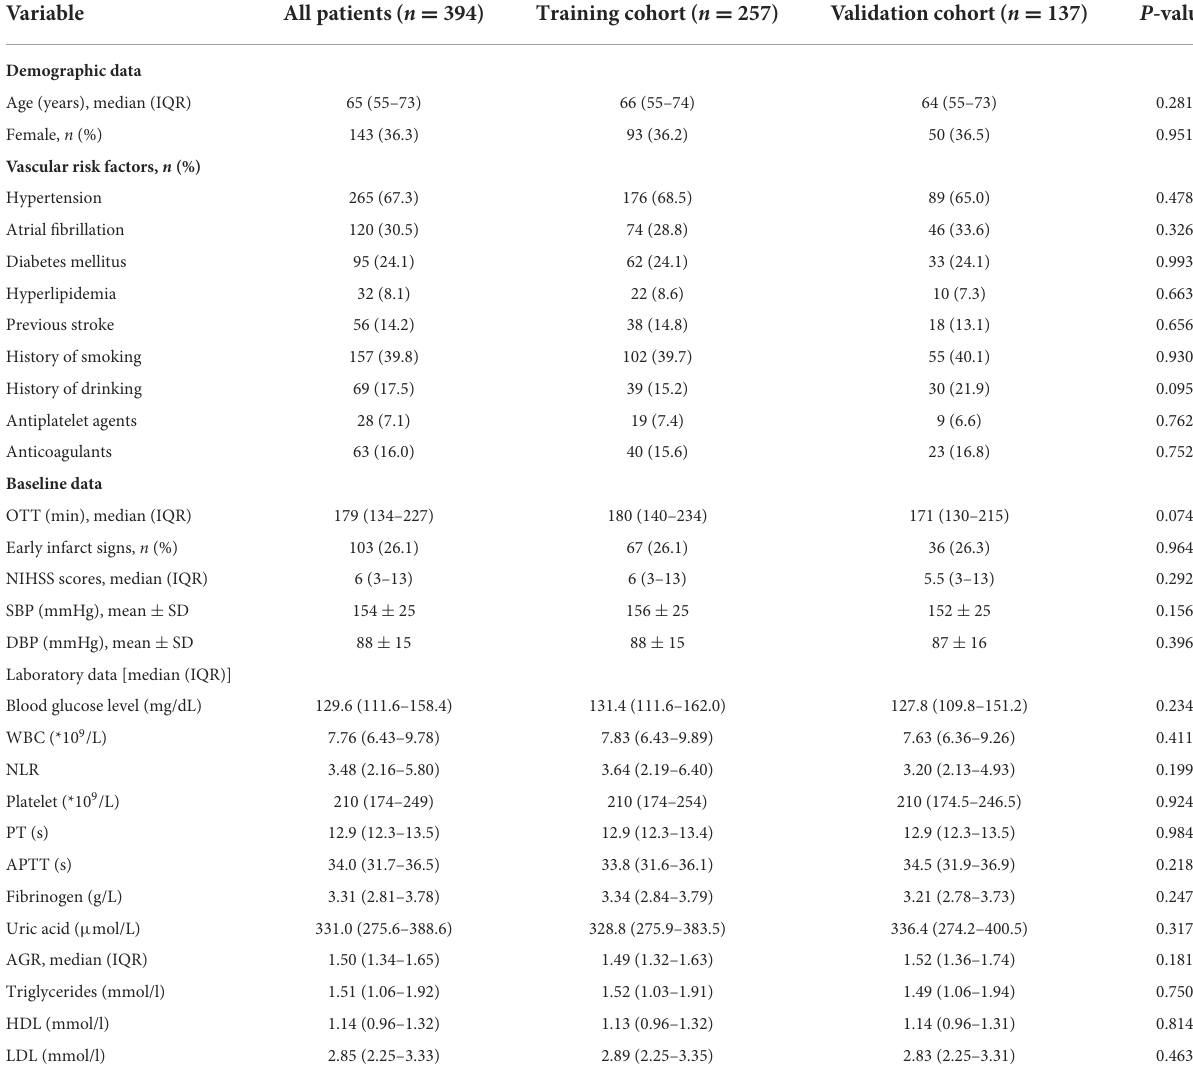
TABLE 1 Comparison of baseline characteristics between the training cohort and validation cohort.